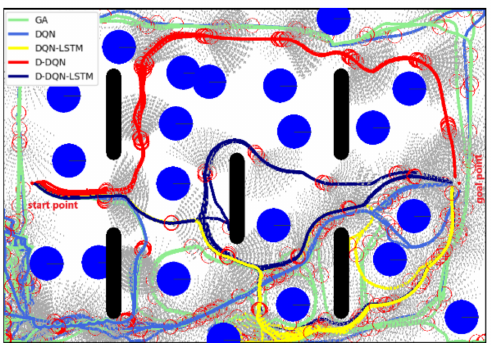
Figure 8. Trajectory graph formed by running all algorithms 100 times in the same